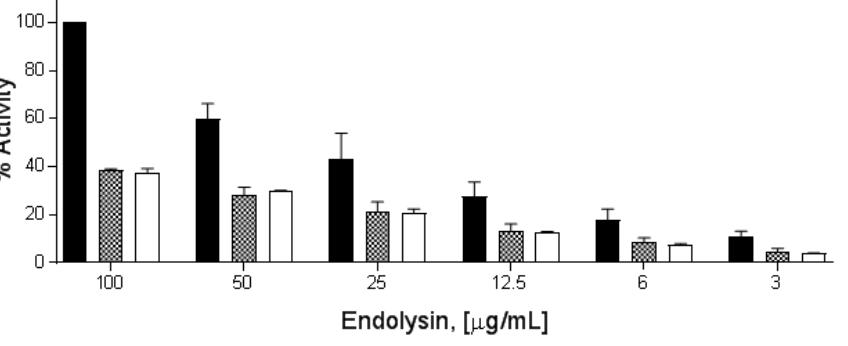
Figure 3. PlyP56, PlyN74, and PlyTB40 lytic activity comparison. Stationary phase B. cereus ATCC 4342 cells at final OD 600 of 1.0 were treated with endolysin doses from 100 μg/mL to 3 μg/mL over 20 min. PlyP56 (black bars), PlyN74 (checker bars), and PlyTB40 (white bars) are indicated. The cell lysis was assayed by turbidity reduction as described in Methods. The % lytic activities were normalized to 100% activity of PlyP56 (black bars) at 100 μg/mL. Experiments were run in triplicates on three independent days. The error bars represent standard deviation.